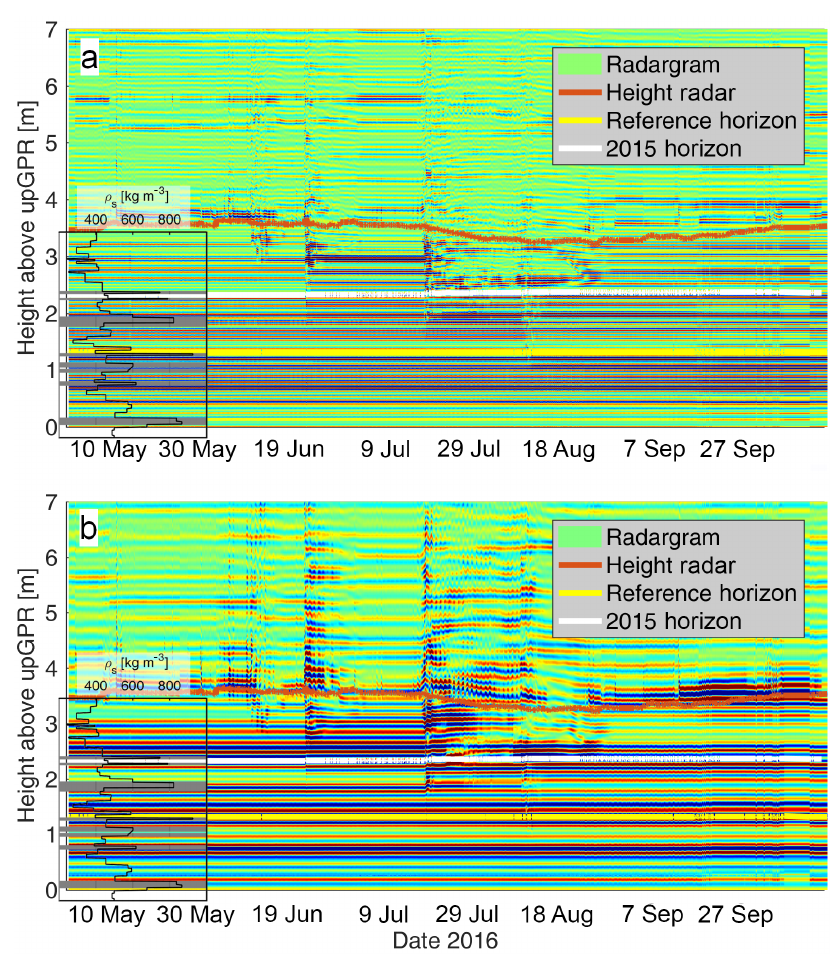
Figure 2. Comparison of dual frequency upGPR data with firn core records gathered for the beginning of May 2016. (a) Reflection responses for the 1600MHz are compared with density and stratigraphy from one firn core with corresponding depth scale. (b) Reflection responses for the 600MHz are compared with density and stratigraphy from one firn core with corresponding depth scale. Occurrences of ice lenses at specific depths are indicated through gray shaded horizontal areas within the boxes. In addition, we display the determined height of the snowpack and firnpack above the antennas (brown line), the height of the reference horizon (yellow line) and the reflection response corresponding to the summer surface of the previous summer (2015 – white